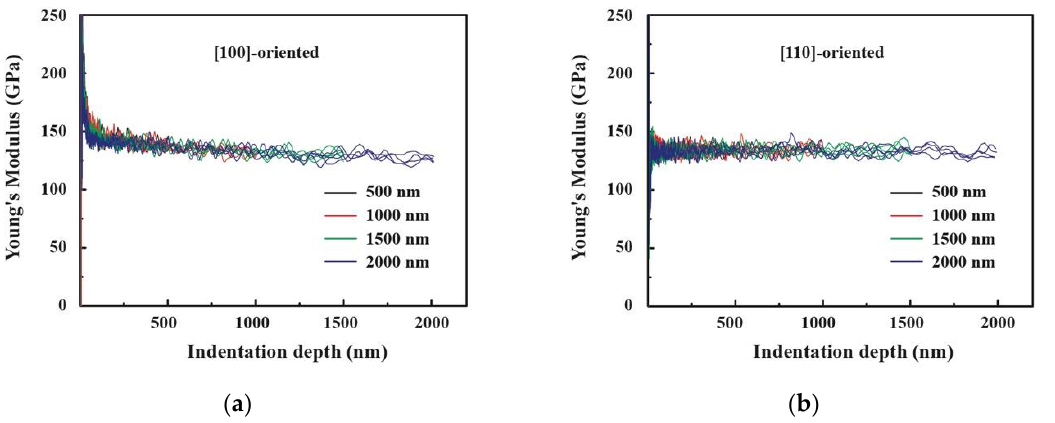
Figure 6. Young’s modulus – indentation depth curves of the ( a ) [100]- and ( b ) [110]-oriented PIN–PMN–PT single crystals at the maximum indentation depths from 500 nm to 2000 nm.